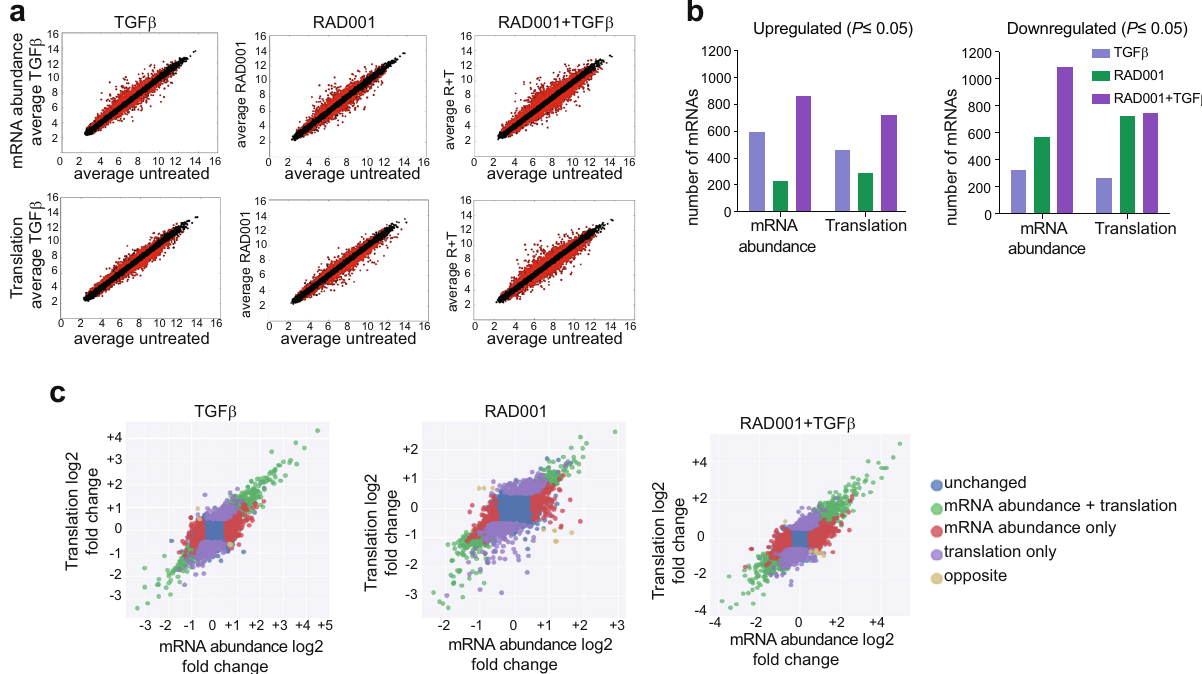
Fig. 5 mTORC1 inhibition with TGF-beta-treatment reprograms the CD4 + T-cell translatome. a Isolation of CD4 + T cells from human peripheral blood mononuclear cells (PBMCs) and treatment carried out from three independent donors as described in Fig. 2a legend. RAD001 + TGF-beta treatment more strongly alters mRNA abundance (transcription) and translation than single treatment with RAD001 or TGF-beta. mRNA abundance and translation values were fi ltered for statistical signi fi cance ( P < 0.05) shown in scatter plots, comparing log 2 -transformed values for each treatment vs. untreated. Transcriptome (mRNA abundance) and translatome (translated) data sets are shown. Each dot represents one gene/mRNA, treated ( Y axis) versus untreated ( X axis). Black dots, genes/mRNAs unchanged between untreated and treated cells. Red dots, genes/mRNAs downregulated or upregulated by treatment. Results shown for three donors, two replicates each. Data analysis involved the use of GCCN and SST transformation algorithms, RMA background correction, limma R package statistics, linear regression models, Fisher ’ s exact tests, and Benjamin – Hochberg corrections for multiple analyses. b Number of statistically signi fi cant ( P < 0.05) transcriptionally or translationally upregulated or downregulated genes/mRNAs for each treatment analyzed as in a . RAD001 + TGF-beta treatment relieves transcriptional inhibition of a pool of downregulated genes through translation, and translationally represses a set of genes upregulated in transcription. c Log 2 scatter plots of transcriptomic and translatomic results for all treatment groups, comparing log 2 changes of translation to mRNA abundance (transcription) for each group. Translation only (translation ef fi ciency) compares translation levels normalized to mRNA levels: mRNA abundance + translation is not normalized to mRNA levels; opposite represents a small number of mRNAs whose translation level is the opposite of the change in mRNA abundance. Source data are provided as Supplementary Data 1 –